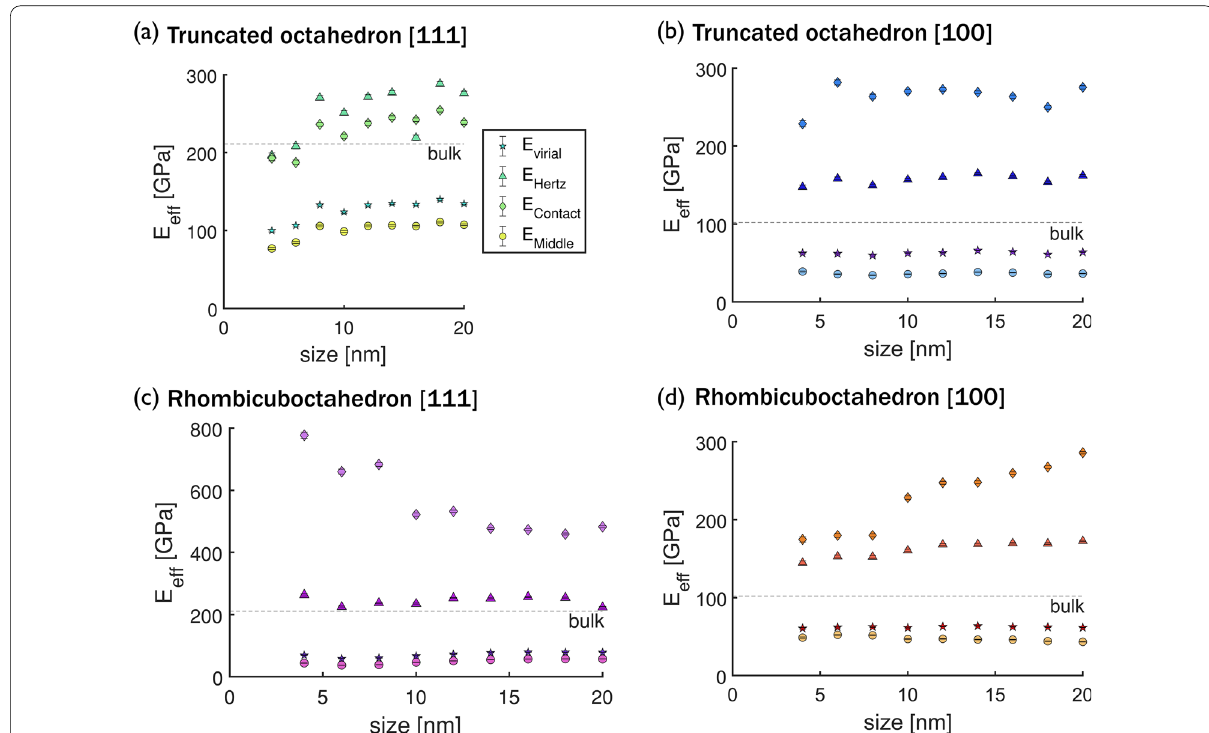
Fig. 2 Size dependence of the effective elastic modulus calculated with different approaches. Effective elastic modulus calculated from the virial stress (stars), Hertz approximation of a rigid cylinder and a half space (triangles), force over contact area (diamond), and force over middle area (square) for two nanoparticle shapes, a , b truncated octahedron and c , d rhombicuboctahedron, and two crystallographic orientations, a , c corresponding to {111} and b , d to {100} orientation. The bulk value calculated from simulations is shown as a dashed